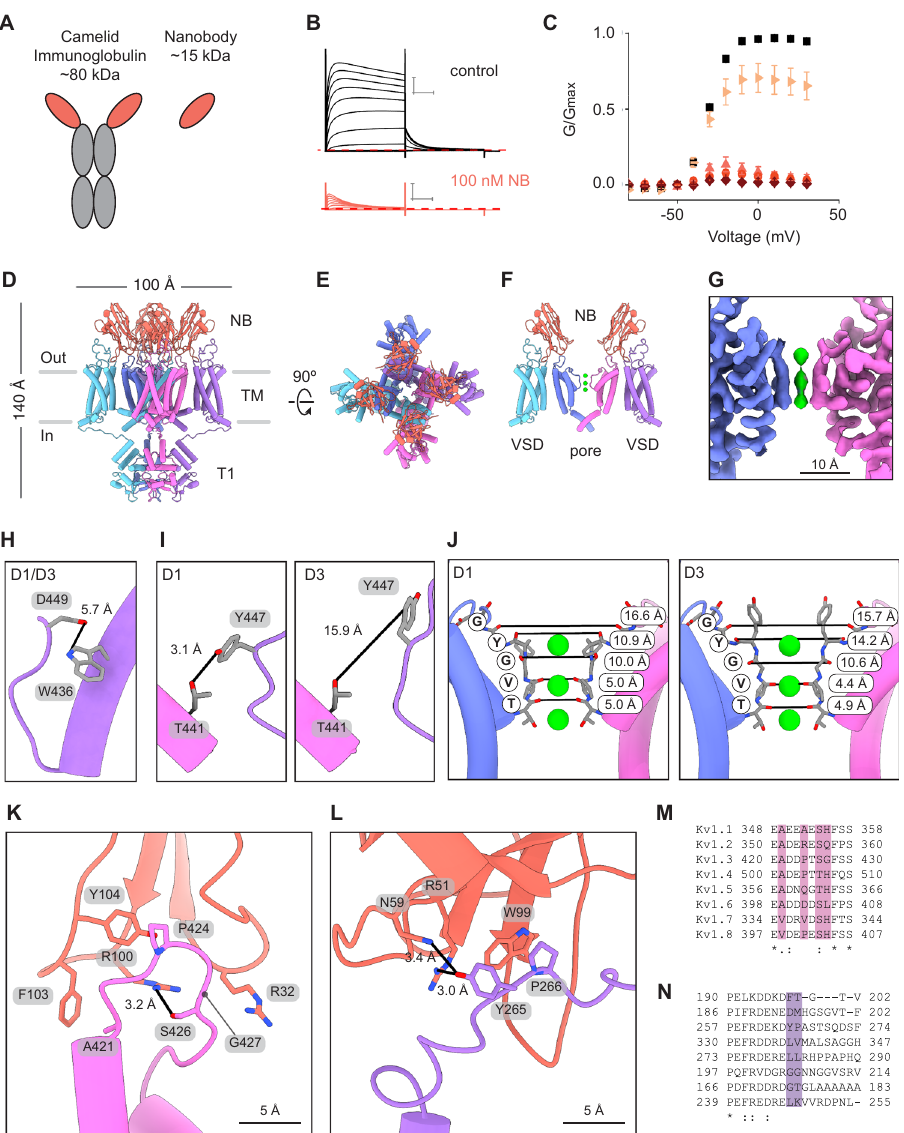
Fig. 3 Multiple nanobodies bind the turret loops and voltage sensing domains of Kv1.3. A Illustration of camelid antibody and nanobody. B Kv1.3 current traces obtained from a family of depolarizing pulses ranging from − 80 mV to + 30 mV in control 2 mM K + solutions (black) and in the presence of 100 nM nanobody (NB) A0194009G09 (orange). Holding voltage was − 80 mV and tail voltage was − 50 mV. Red dotted line denotes zero current level. Scale bars indicates 2 μ A and 50 ms. C G-V relations obtained in control 2 mM K + solutions (black squares; n = 20), 1 nM (right facing triangles, light orange; n = 7), 10 nM (upright triangles, pink; n = 3), 100 nM (circles, orange; n = 7) or 1 µ M nanobody (diamonds, dark red; n = 3) by measuring the peak of the tail current at − 50 mV and normalizing it to the maximum tail current in control solution. Error bars are SEM. Side ( D ) and extracellular ( E ) views of the model for Kv1.3 in complex with four nanobodies (orange). F Cutaway view of the structure in ( D ) showing two nanobodies with each bound to a pore domain and a VSD of Kv1.3. The T1 domains are omitted for clarity. G Cryo-EM density of the pore region (C1 symmetry). H , I Views of W436/D449 and T441/Y447 for both the D1 and D3 conformations identi fi ed in the Kv1.3-nanobody structure. J Structures of the selectivity fi lter of the Kv1.3-nanobody complex with the D1 (left) and D3 (right) conformations. Distances between carbonyl oxygens of the TVGYG motif are reported and marked with black lines. K + ions shown in green. Close up views of a nanobody in complex with a turret loop of a pore domain ( K ) and the S1-S2 loop of a VSD ( L ). Sequence alignment for the turret loop ( M ) and VSD S1-S2 loop ( N ) regions for human Kv1 channels. Source data are provided as a Source Data fi